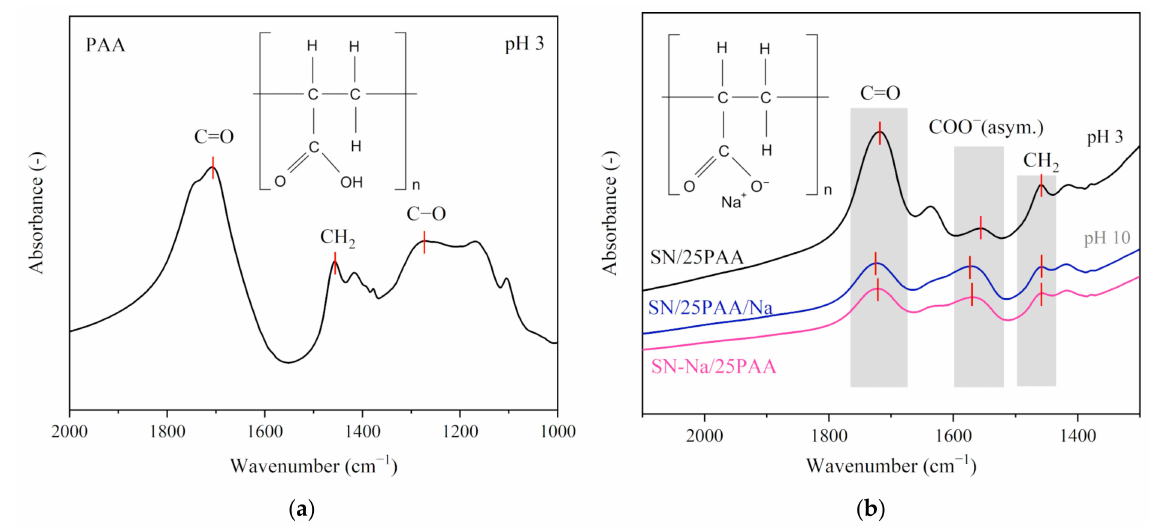
Figure 4. ( a ) IR spectra of poly(acrylic acid); ( b ) IR spectra of SN/25PAA, SN/25PAA/Na, SN-Na/25PAA composites in the wavenumber range corresponding to the presence of the polymer carboxyl group and carboxylate